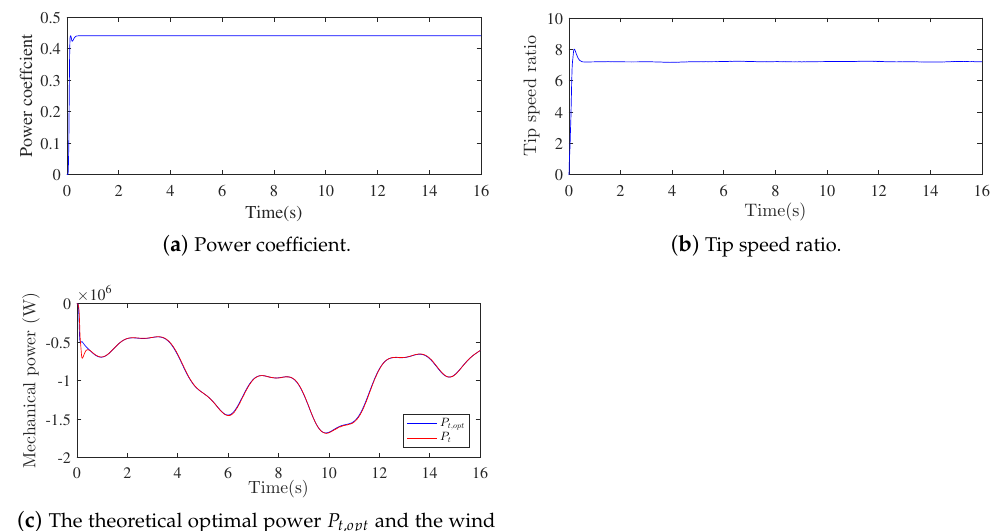
Figure 11. The wind turbine characteristics. Figure 12 represents the stator reactive power exchanged with the grid. The reactive power tended towards zero, which means that in the stator–grid association, only the stator active power was exchanged with the grid. This guaranteed the achievement of the unitary power factor objective.